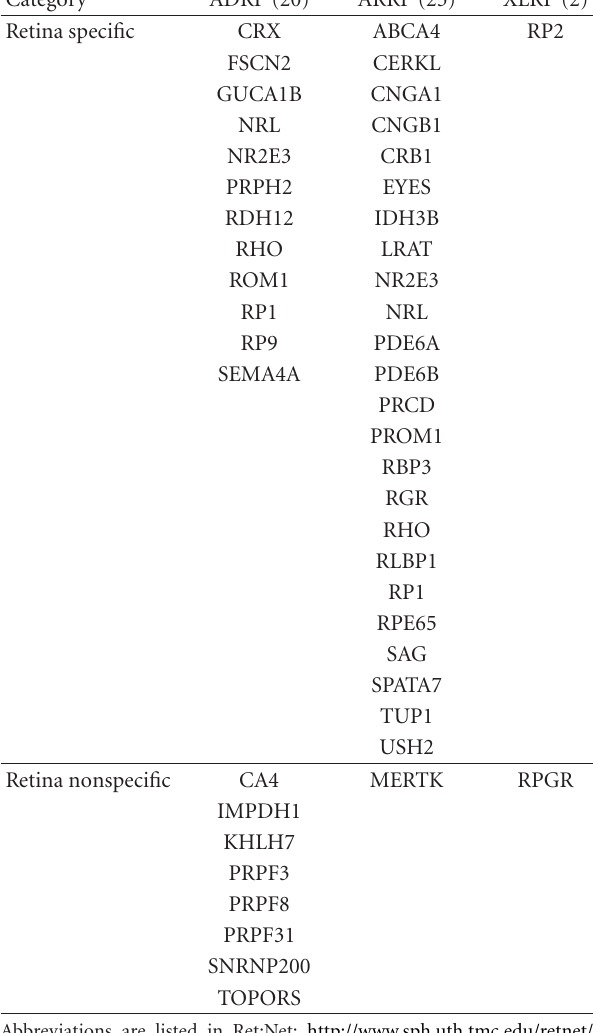
Table 1: List of causative genes of RP: retina specific and